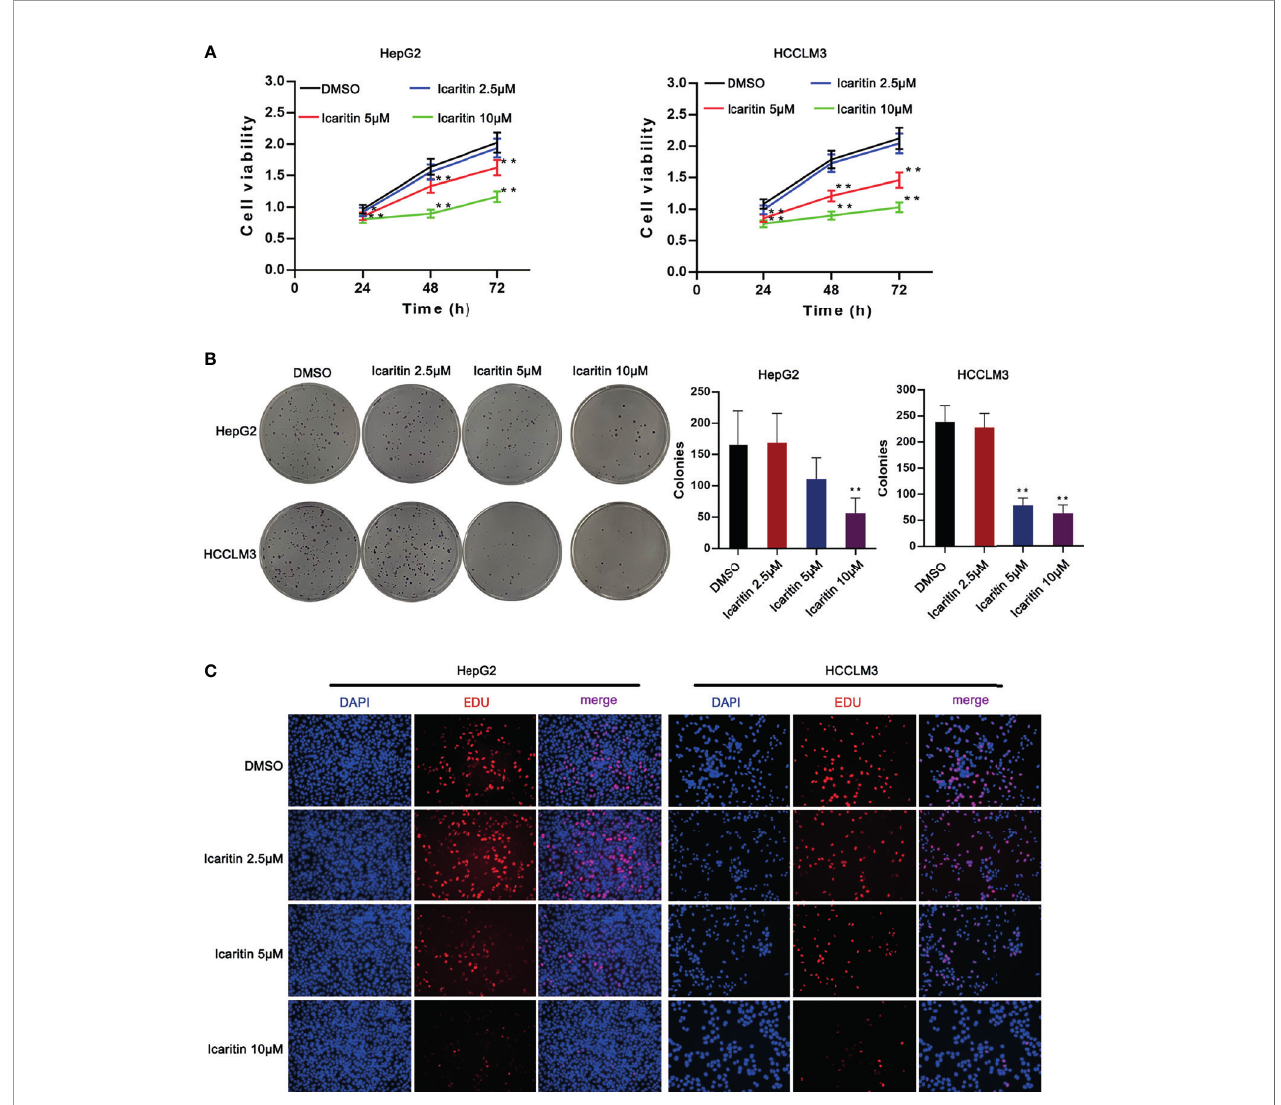
FIGURE 1 | Icaritin affected the proliferation of HCC cells. (A) HCC cell viability was detected after the treatment of icaritin of different concentrations by MTT assay. (B) Pictures of colonies and quanti fi cation of colony number generated by HCC cells under the treatment of different doses of icaritin. (C) Pictures of EdU-stained proliferative HCC cells under the treatment of different doses of icaritin. * p < 0.05, ** p <